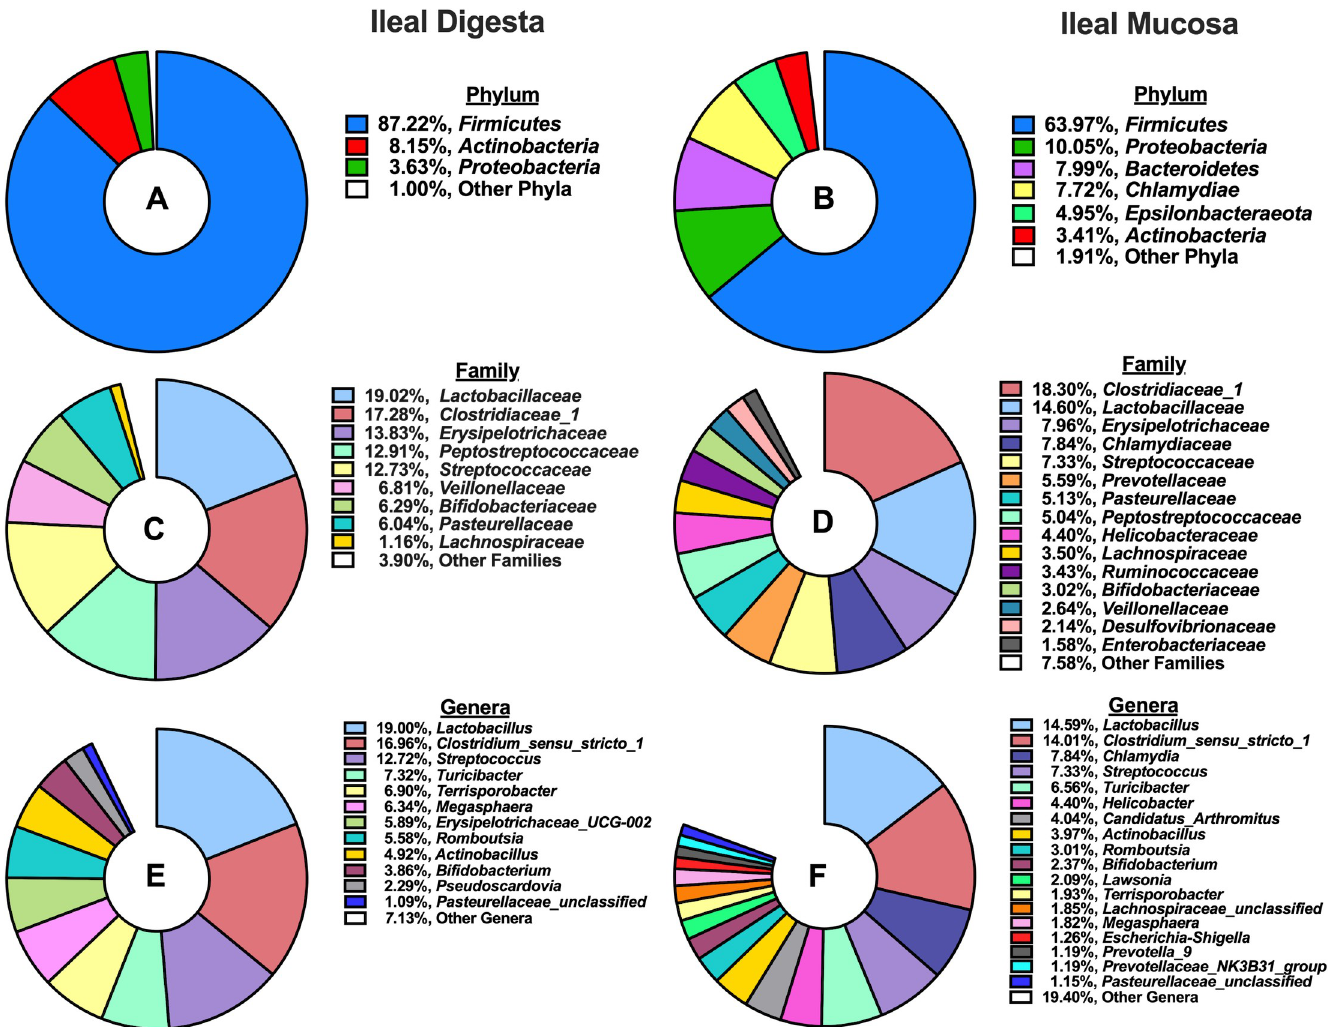
Fig 1. Summary of phylum, family, and genus-level microbial composition ( > 1% relative abundance) in the ileal digesta and mucosa among pigs (N = 60): A) Relative abundance of phyla present in the ileal digesta; B) Relative abundance of phyla present in the ileal mucosa; C) Relative abundance of families present in the ileal digesta; D) Relative abundance of families present in the ileal mucosa; E) Relative abundance of genera present in the ileal digesta; F) Relative abundance of genera present in the ileal mucosa.